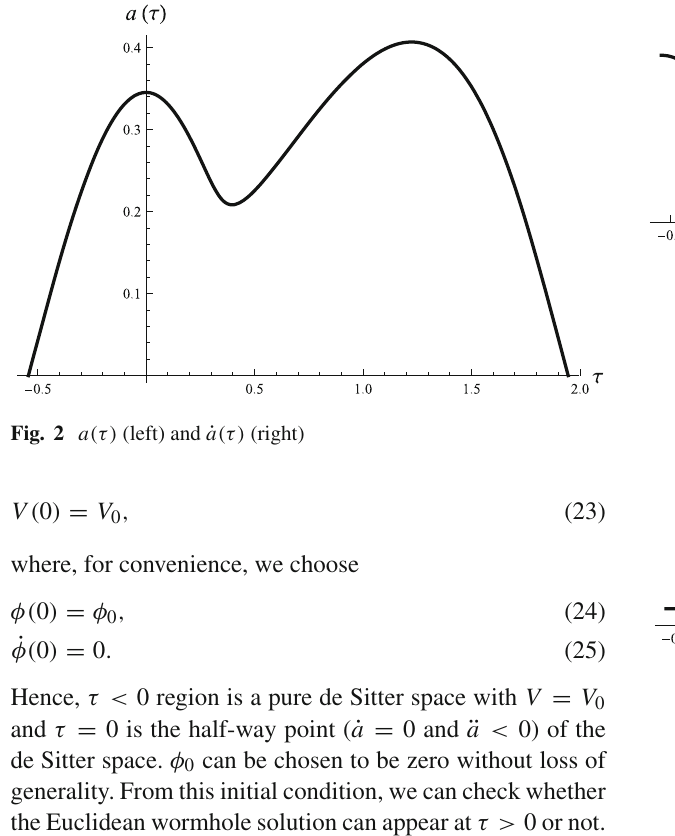
Fig. 2 a (τ) (left) and ˙ a (τ) (right)